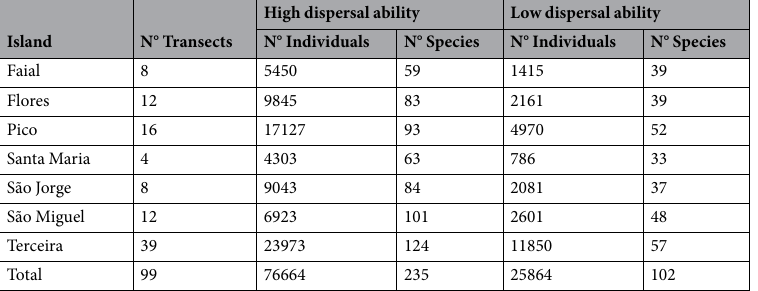
Table 1. Number of species and individuals of arthropods in the categories of high and low dispersal ability, for the samples collected in each of the Azorean islands. The data were collected from 1999 to 2012 along transects (each 150 m long by 5 m wide) in 18 fragments of native forest. The sampling effort was the same for all transects and consisted of 30 pitfall traps, spaced 5 m apart, for epigean arthropods, and a maximum of 30 samples for canopy arthropods, consisting of 10 samples for each of three dominant plants in the transect. Note that the results presented in the main text refer only to Pico Island and to Terceira Island. Results for the other islands can be found in Supplementary Figs